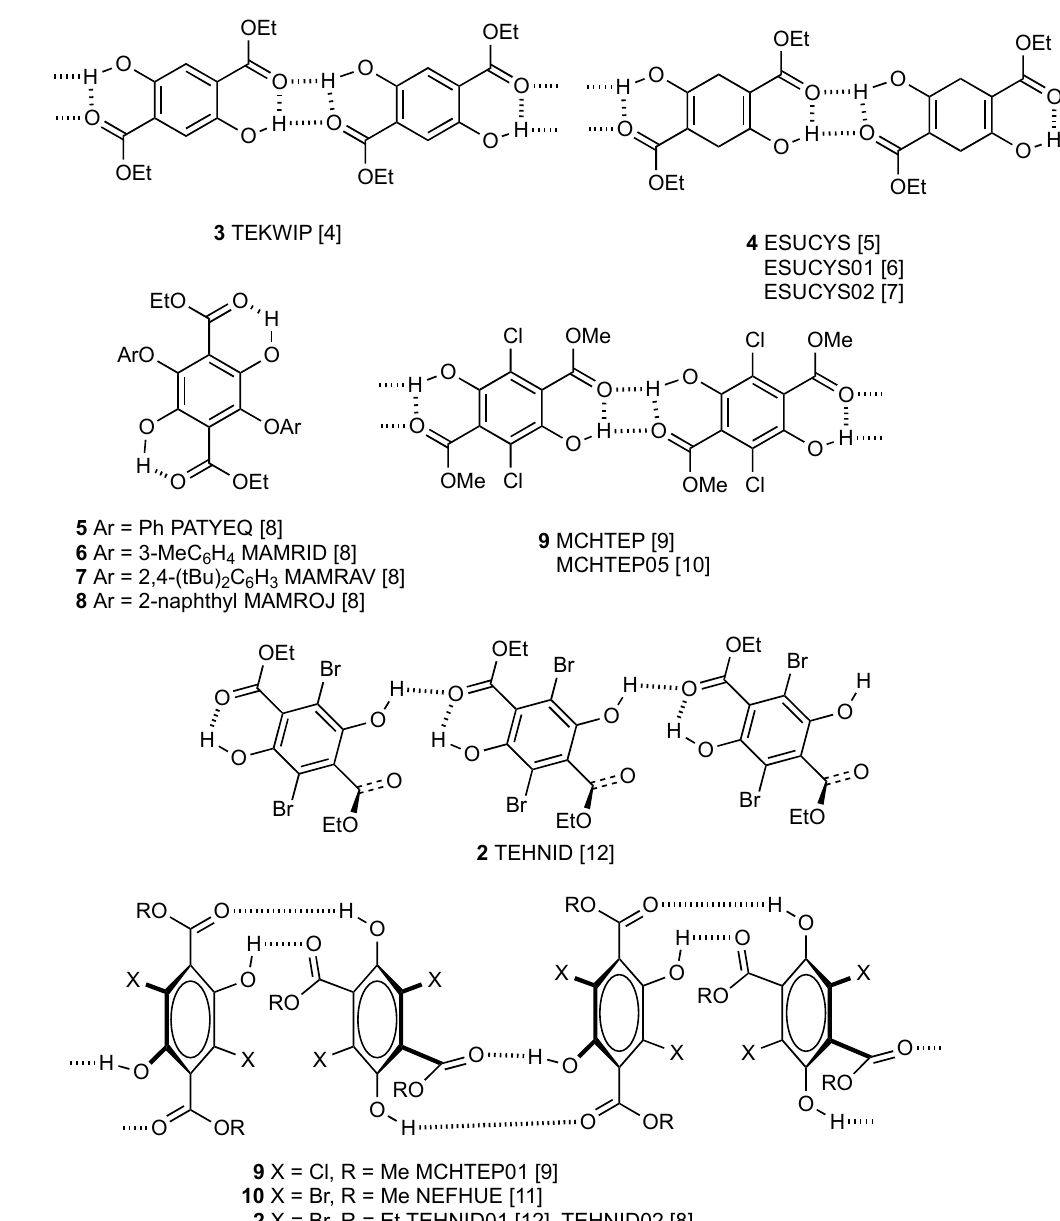
Figure 3. Structure of hydrogen-bonded stacks and schematic representation.